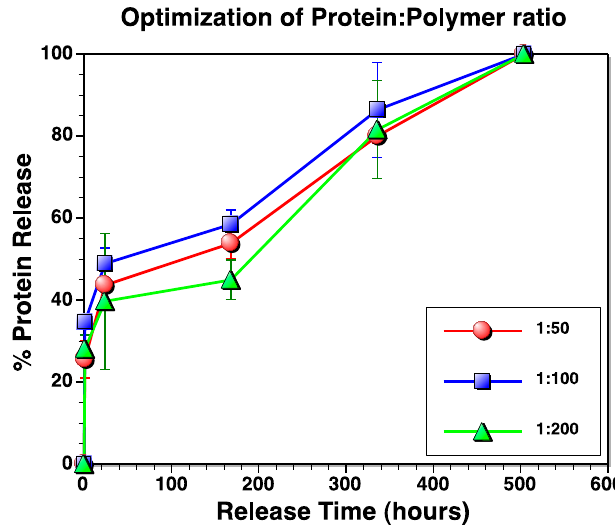
Figure 3. Optimization of protein loading. All polymer films were cross-linked with 0.25 vol % GA. Release rates were similar even in the case of different protein to polymer loading ratios.